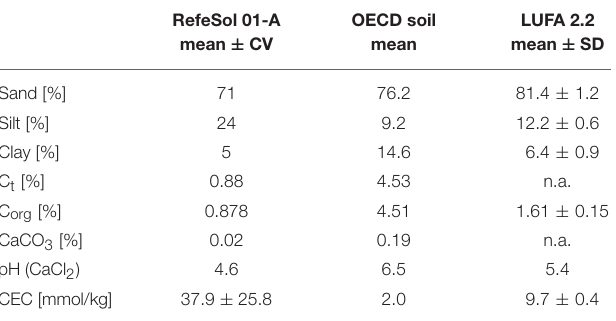
TABLE 1 | Characteristics of the soils used for the F. candida reproduction